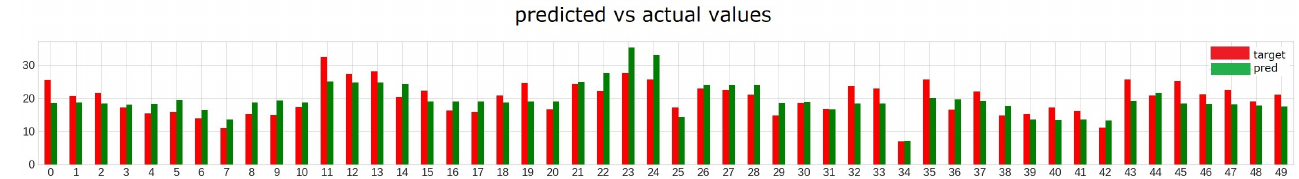
Figure 9. Validation of the